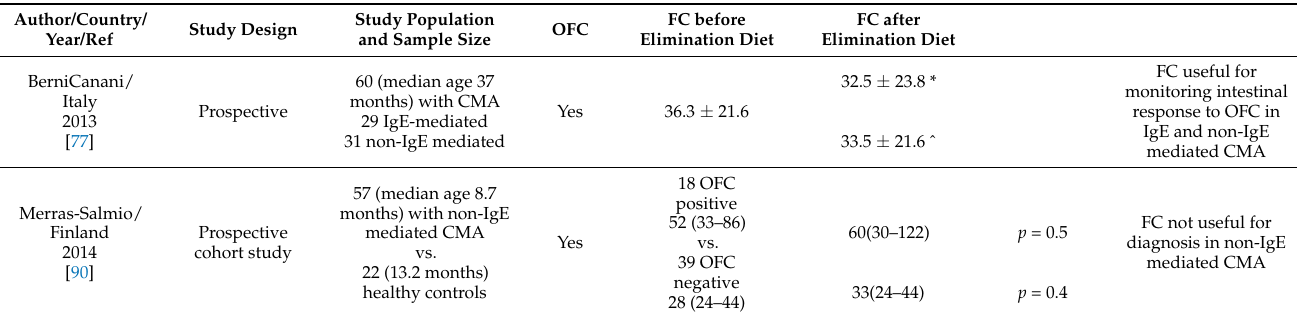
Table 4. Fecal calprotectin in